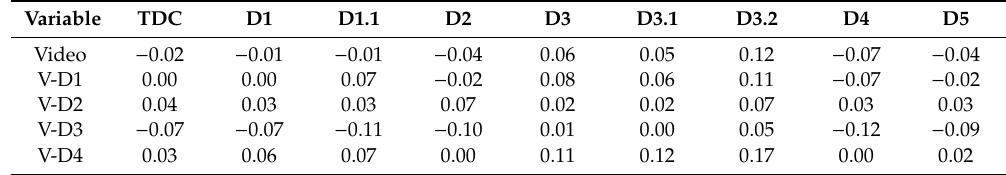
Table A2. Results of the Spearman Rho test used to assess possible correlations between the video scores and associated dimensions and the TDC self-assessments and associated dimensions D1, D2, D3, D4, and D5, and associated sub-dimensions D1.1, D3.2, and D3.2. Variable TDC D1 D1.1 D2 D3 Video − 0.02 −